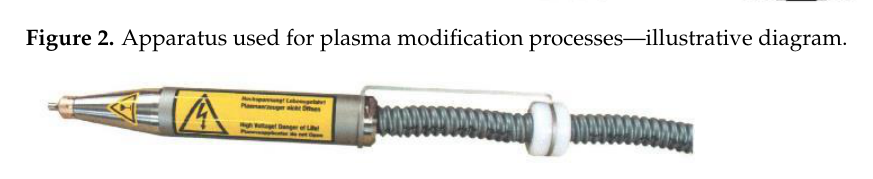
Figure 3. Nozzle used for plasma functionalisation.